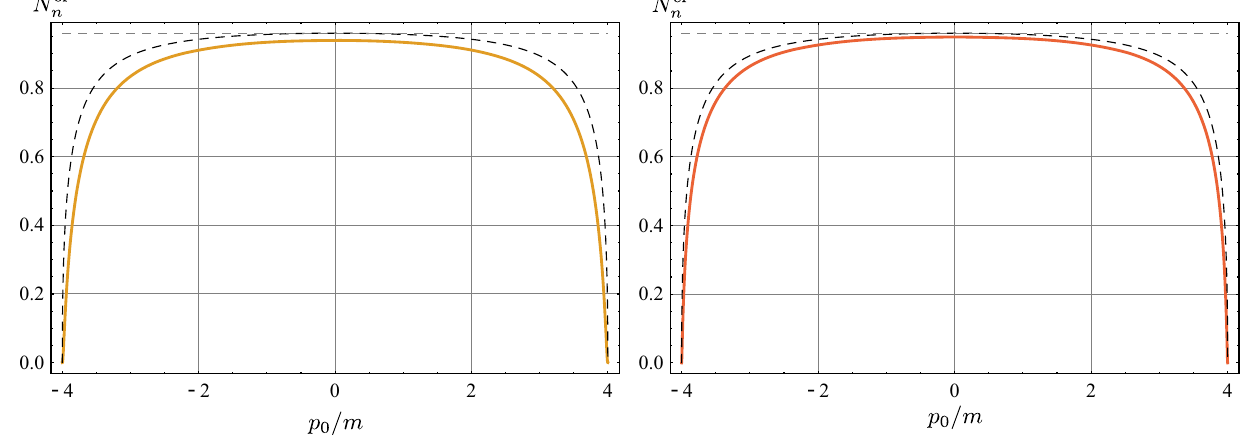
E = 500 E c and m ξ 1 = m ξ 2 = 1 / 100. The magnitude of the potential energy step is constant for both plots U / m = 5 = const . and so is the extension of the Klein zone, which is | p 0 | / m ≤ 4. The horizontal dashed lines denote the maximum value